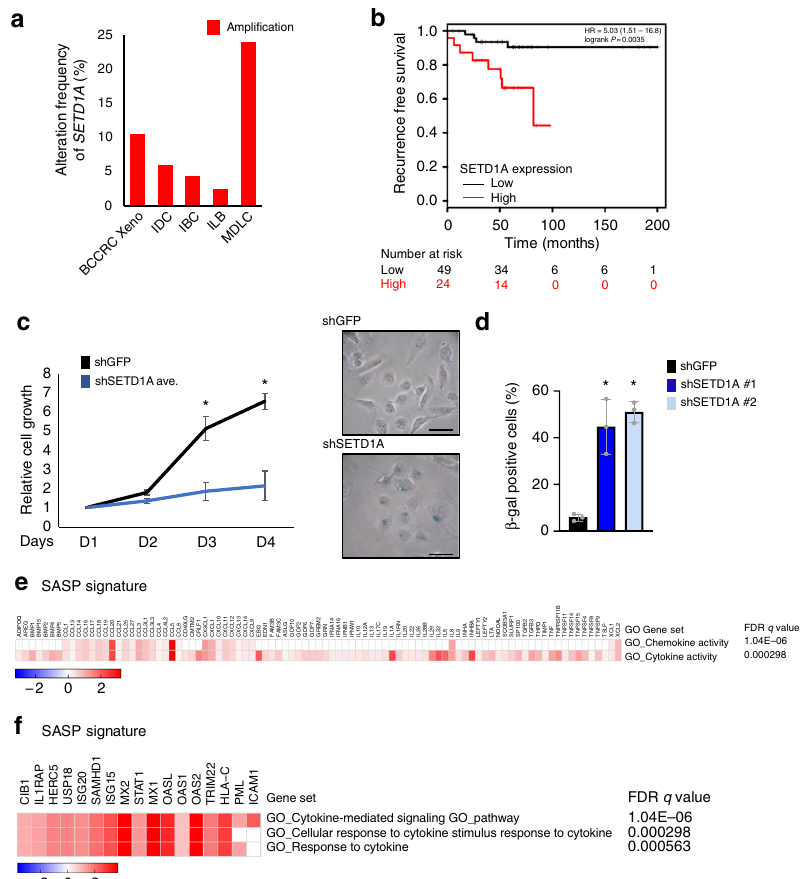
Fig. 1 SETD1A expression protects cells from senescence. a SETD1A is ampli fi ed in breast cancer. Publicly available data from 935 breast cancers (http:// www.cbioportal.org/) was evaluated for SETD1A gene ampli fi cation. The frequency of ampli fi cation in mixed ductal and lobular (MDLC), invasive